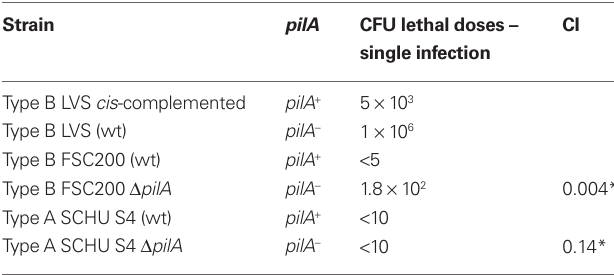
Table 2 | Comparison in infection doses and CI values for pilA positive and pilA negative strains.